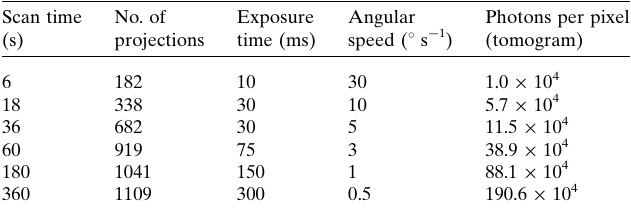
Table 4 Parameters of the tomographic scans displayed in Fig. 3.